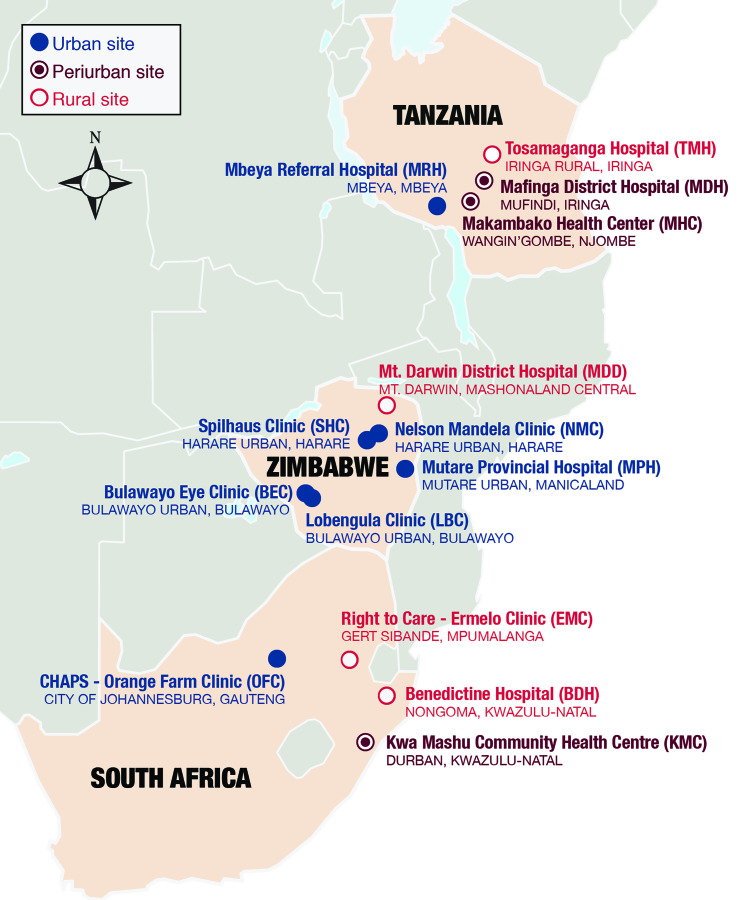
Map of study sites.